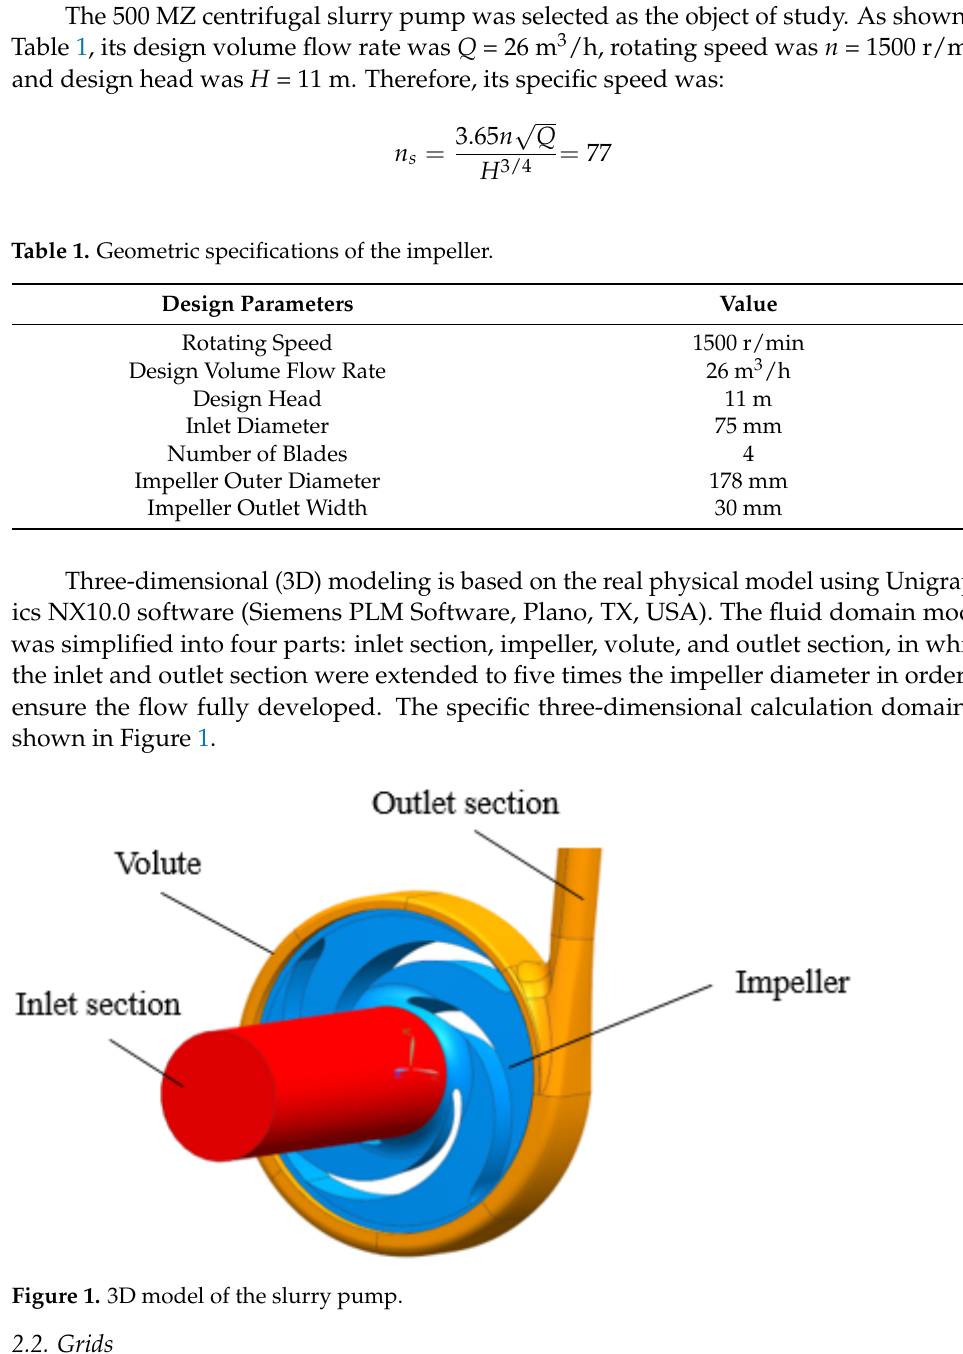
Figure 1. 3D model of the slurry